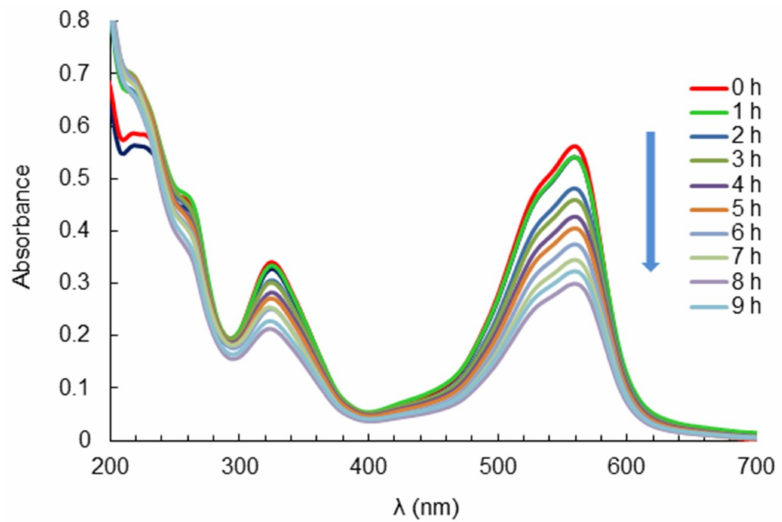
Figure 7. Absorption spectrum of Reactive Violet 5 (RV5) during the photocatalytic